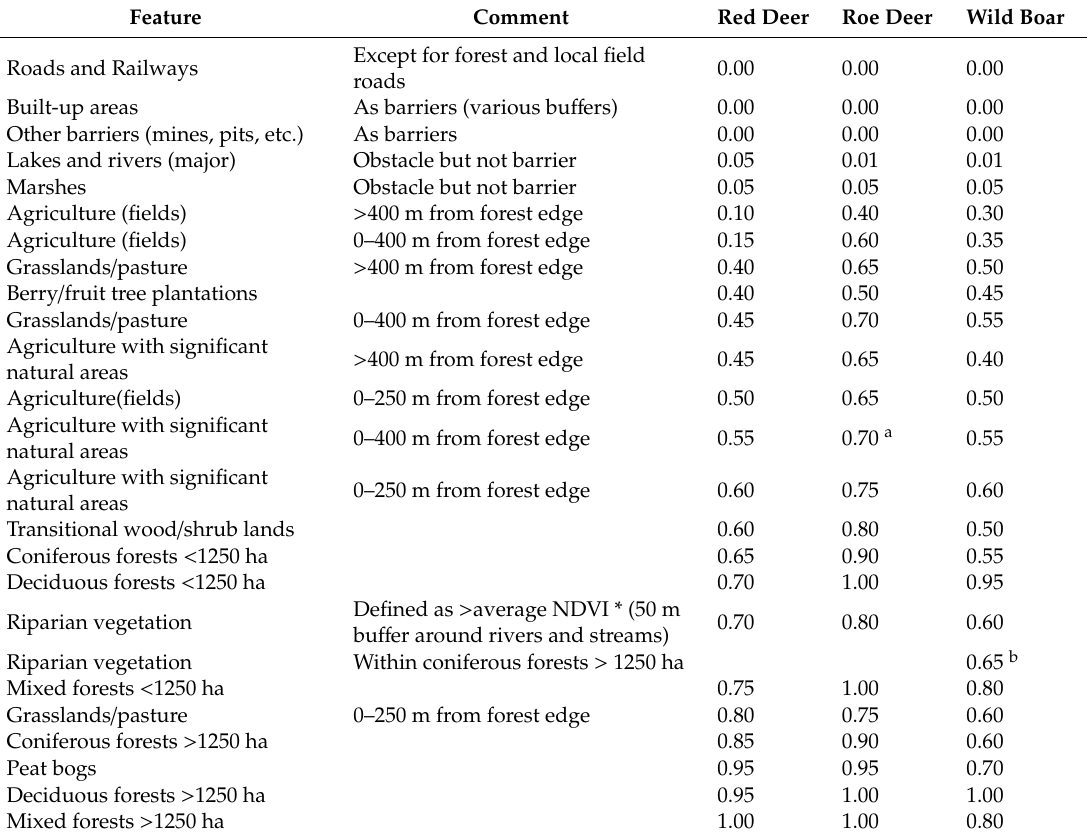
Table 1. Relative ranking of red deer, roe deer and wild boar habitat components based on a literature review and expert opinion (see also Table